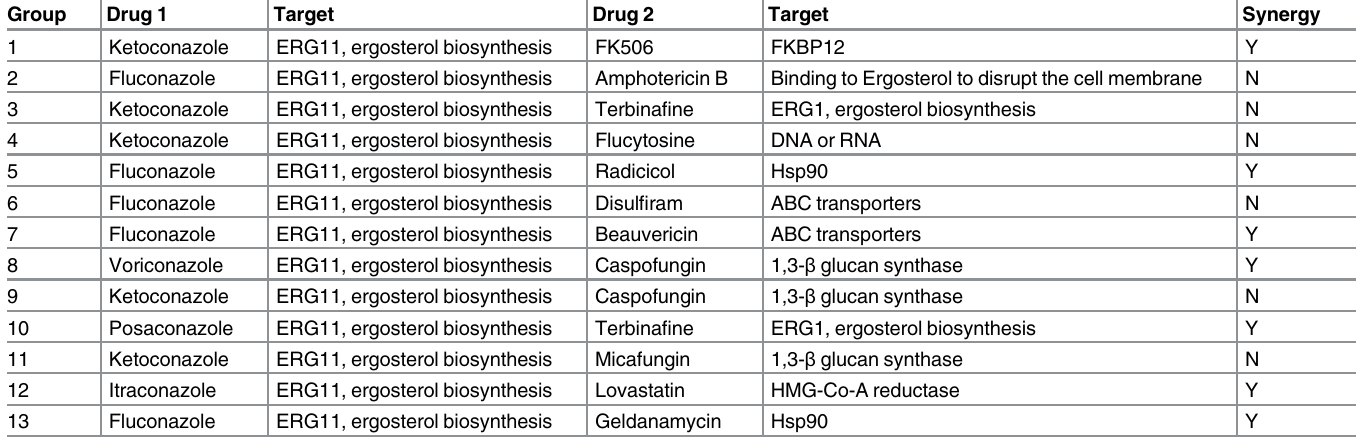
Table 3. Biological experimental results for potential top 10 antifungal drug combinations in three drug combination datasets, and the targets for the drugs are shown here. In total, 13 drug combinations have been predicted to be the top 10 potential combinations. Seven combinations have been con- firmed to be synergistic by antifungal biological